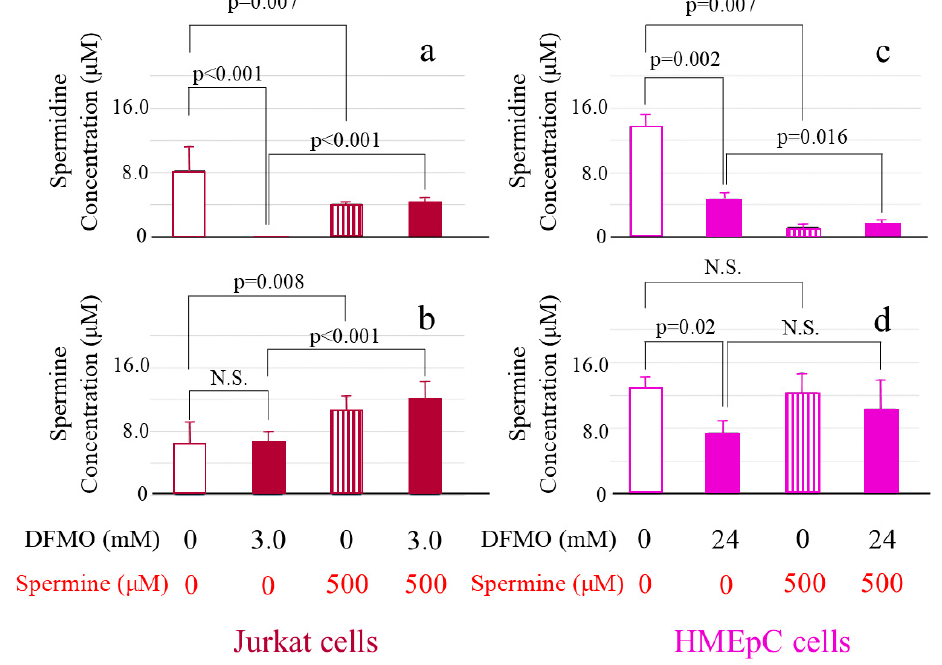
Figure 3. Changes in intracellular polyamine concentrations in cells cultured with D,L-alpha-difluoromethylornithine (DFMO) and spermine. Cells cultured for 72 h in different conditions were collected and intracellular polyamine concentrations were determined by reversed-phase high-performance liquid chromatography (HPLC). ( a ): Intracellular spermidine concentrations in Jurkat cells. ( b ): Intracellular spermine concentrations in Jurkat cells. ( c ): Intracellular spermidine concentrations in human mammary epithelial cells (HMEpCs). ( d ): Intracellular spermine concentrations in HMEpCs. Data are shown as means and standard deviations of six samples ( n = 6) for each culture condition. N.S.: not significant.